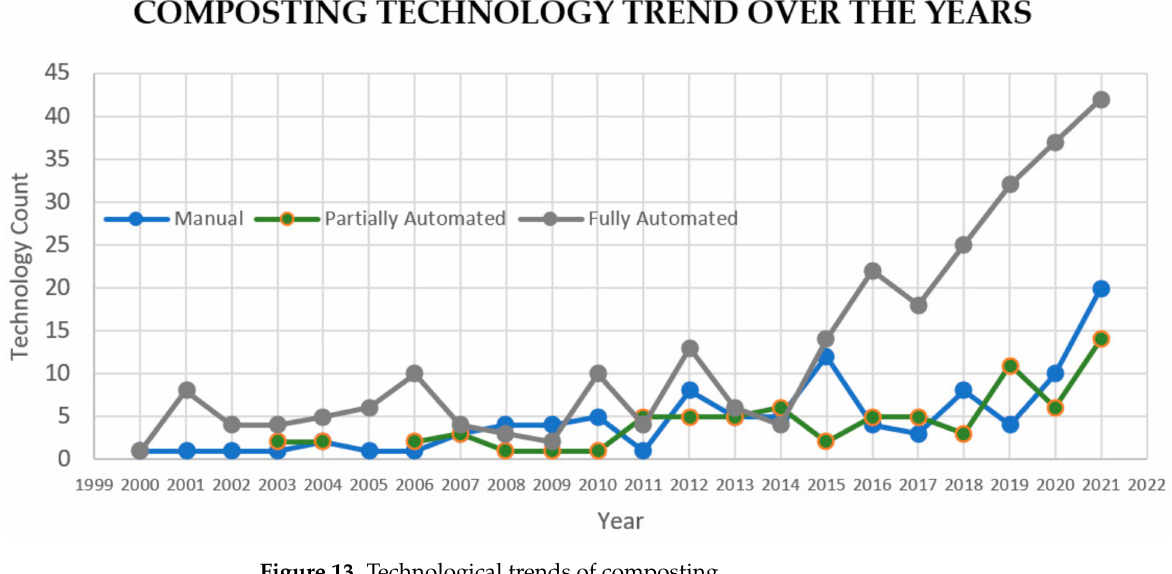
Figure 13. Technological trends of composting.